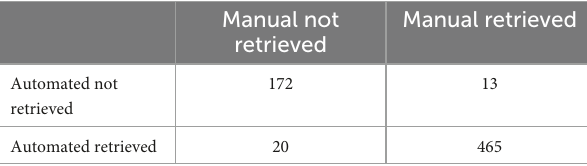
TABLE 2 Confusion matrix corrected